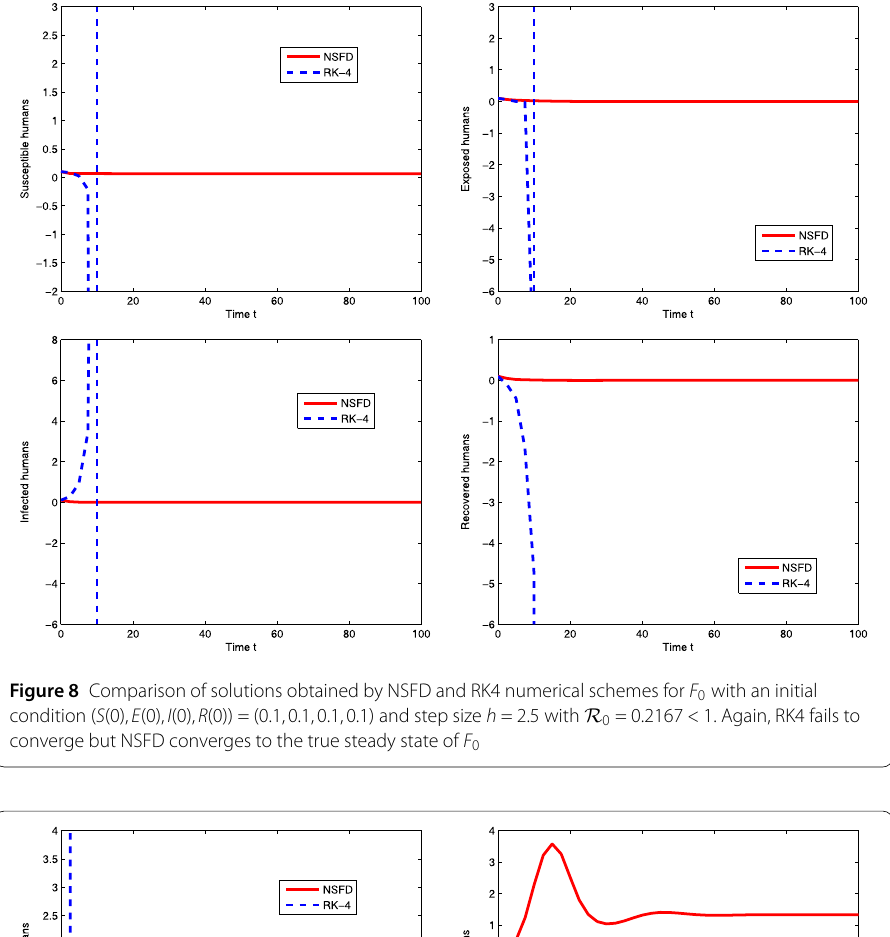
Figure 8 Comparison of solutions obtained by NSFD and RK4 numerical schemes for F 0 with an initial condition ( S (0), E (0), I (0), R (0)) = (0.1,0.1,0.1,0.1) and step size h = 2.5 with R 0 = 0.2167 < 1. Again, RK4 fails to converge but NSFD converges to the true steady state of F 0